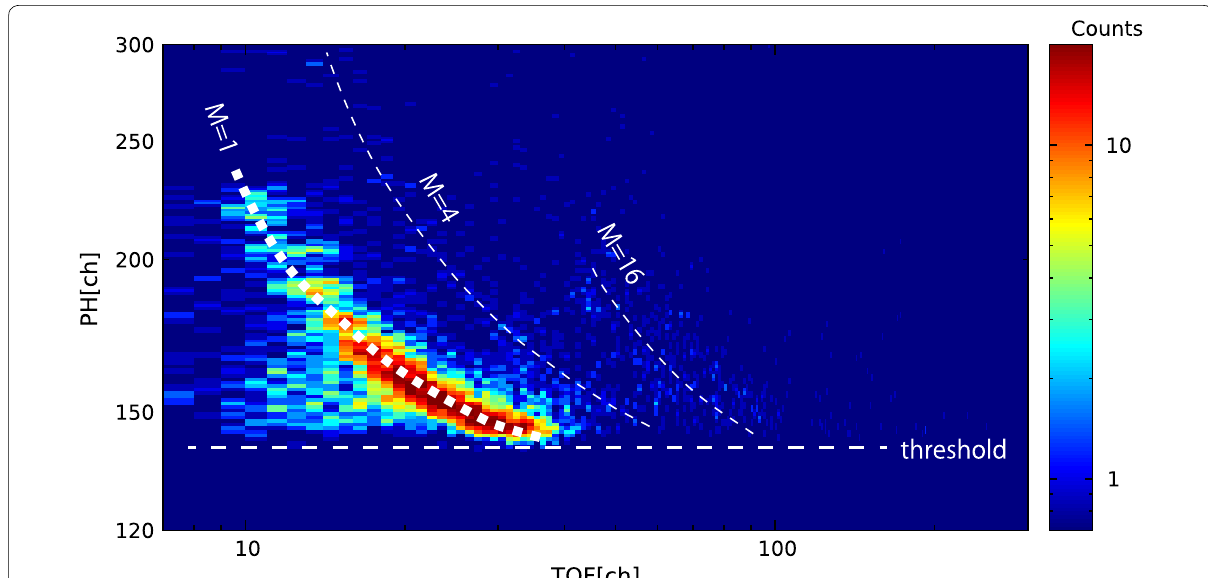
Fig. 14 TOF-PH (corresponding E ) profile of ions measured by the MEP-i during 8–16 UT on August 4, 2017. The profile was derived from the list data in the Normal